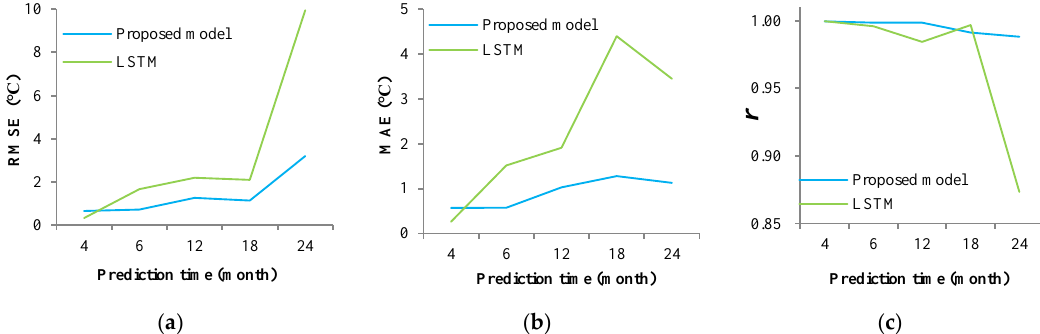
Figure 10. Prediction accuracy for different monthly lengths of the P2 site. ( a ) RMSE with different prediction length; ( b ) MAE with different prediction length; ( c ) r with different prediction length.